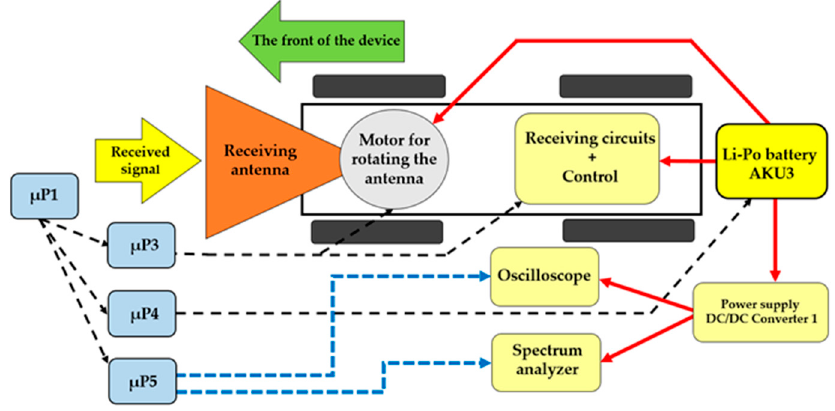
Figure 18. Block diagram of the remote-controlled mobile interference device in reception mode.